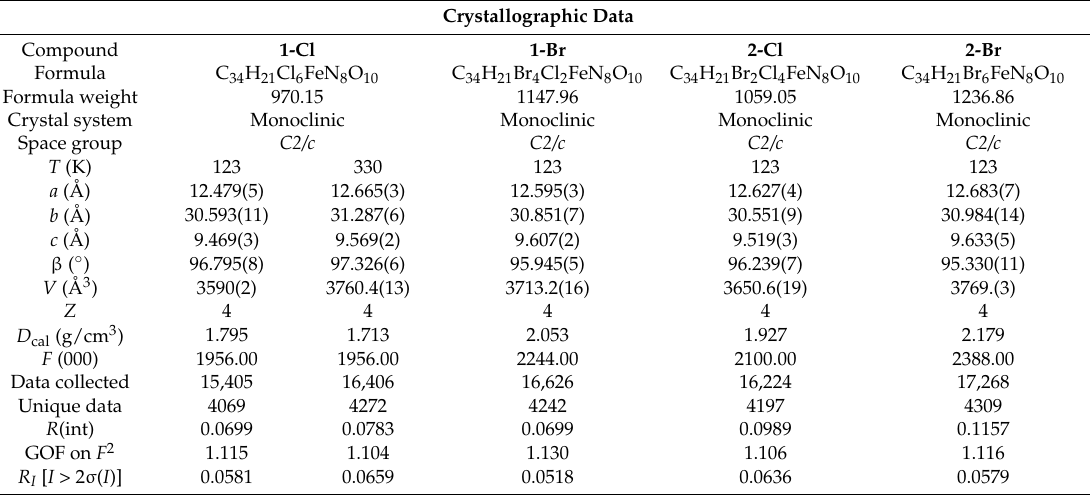
Table 2. Coordination and hydrogen bond distances in 1-Cl , 1-Br , 2-Cl , and 2-Br